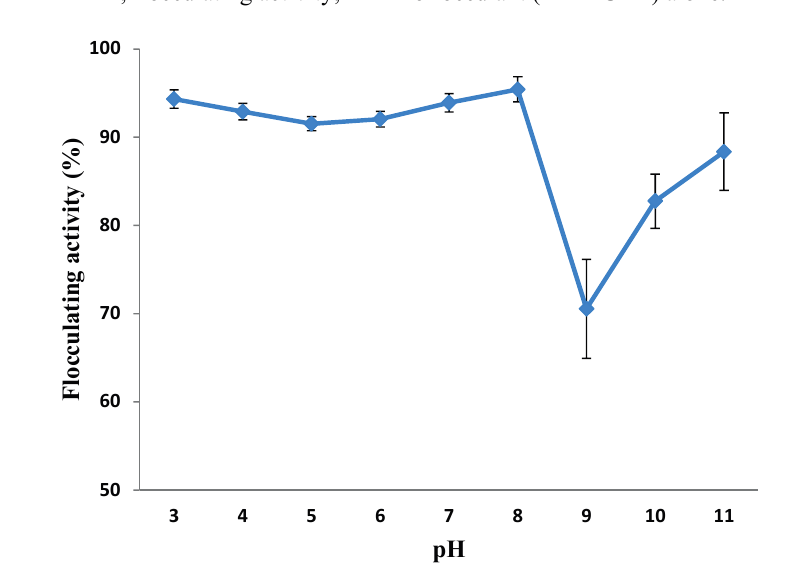
Figure 5. Effect of pH on the flocculating activity of purified MBF-UFH produced by Bacillus sp.